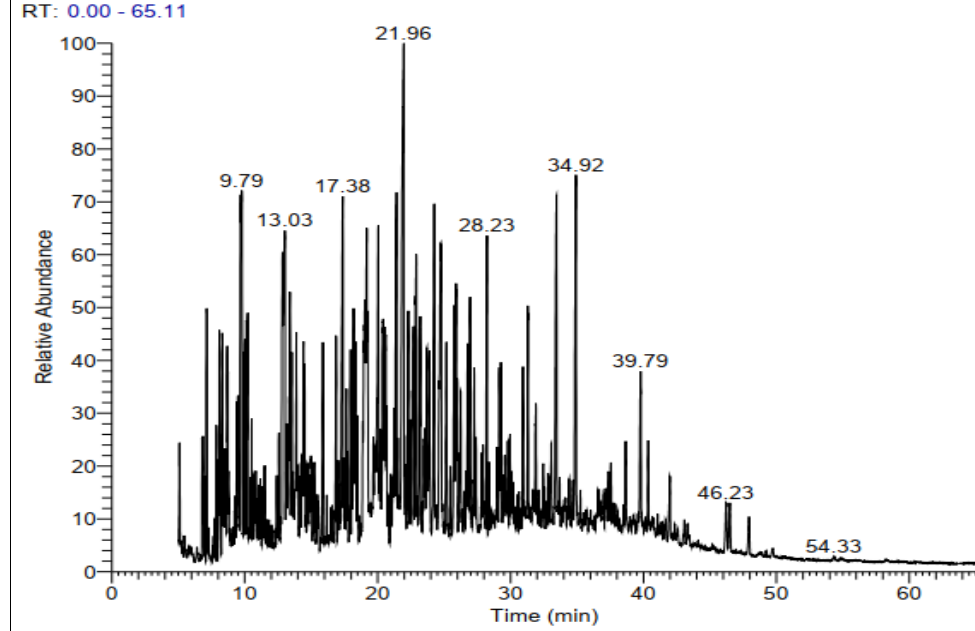
Figure 2. Representative GC-MS chromatogram of derivatized methanolic extract of C. mixtus leaves.